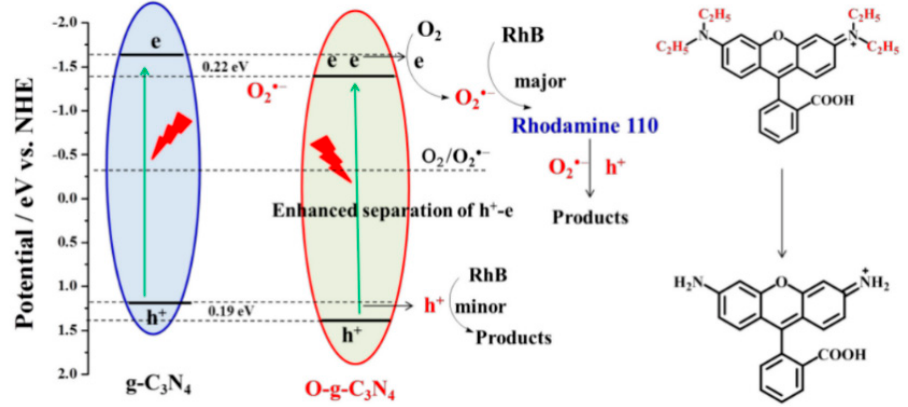
Figure 12. The scheme of the RhB photocatalytic degradation in the presence of O-g-C 3 N 4 . Reprinted from [17].